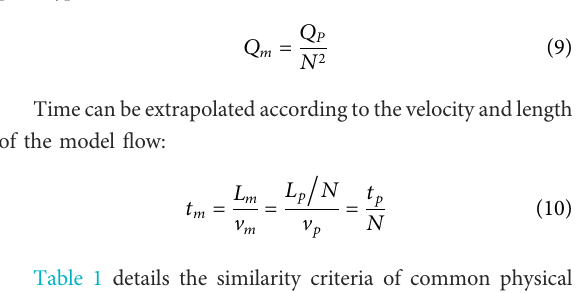
Table 1 details the similarity criteria of common physical quantities in centrifugal model tests.